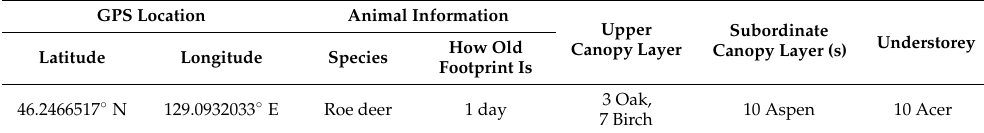
Table 1. Example of field data collection.